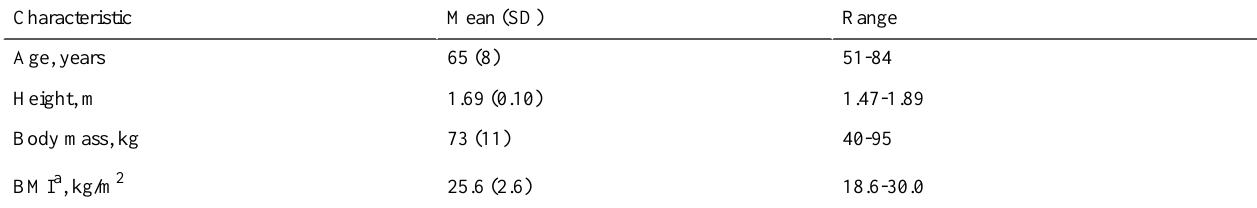
Table 1. Subject characteristics (N=42, 19